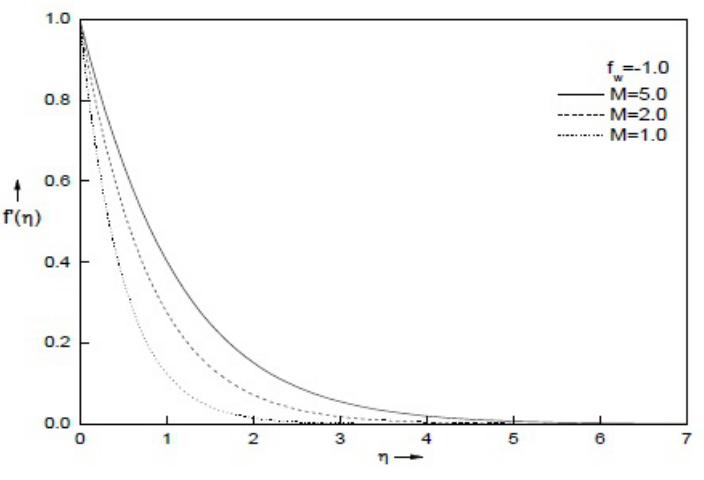
Fig. 5 Velocity profiles f (cid:48) ( η ) for various values of magnetic parameters M for f w = − 1 . 0.